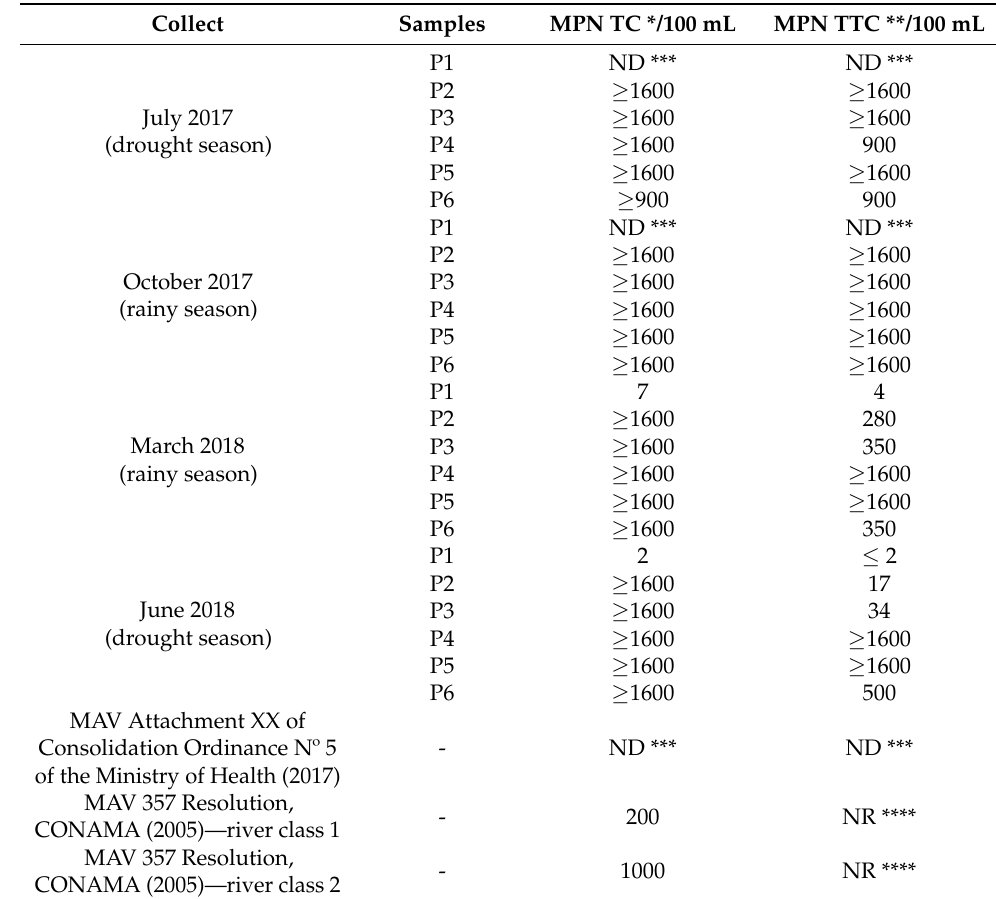
Table 2. Bacterial count of water samples, by most probable number, from Buritis Lake and maximum allowed value according